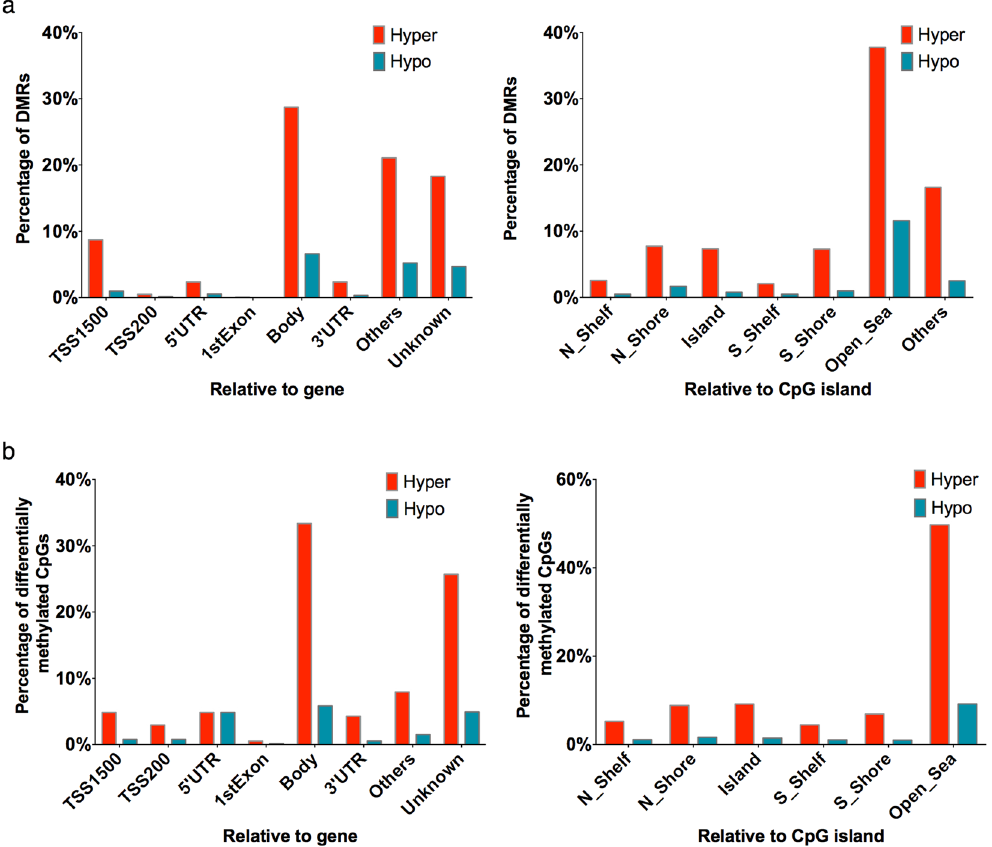
Figure 4. Location of differentially methylated sites and regions in relation to functional subregions and CpG islands. ( a ) Region-level analysis. ( b ) CpG-level